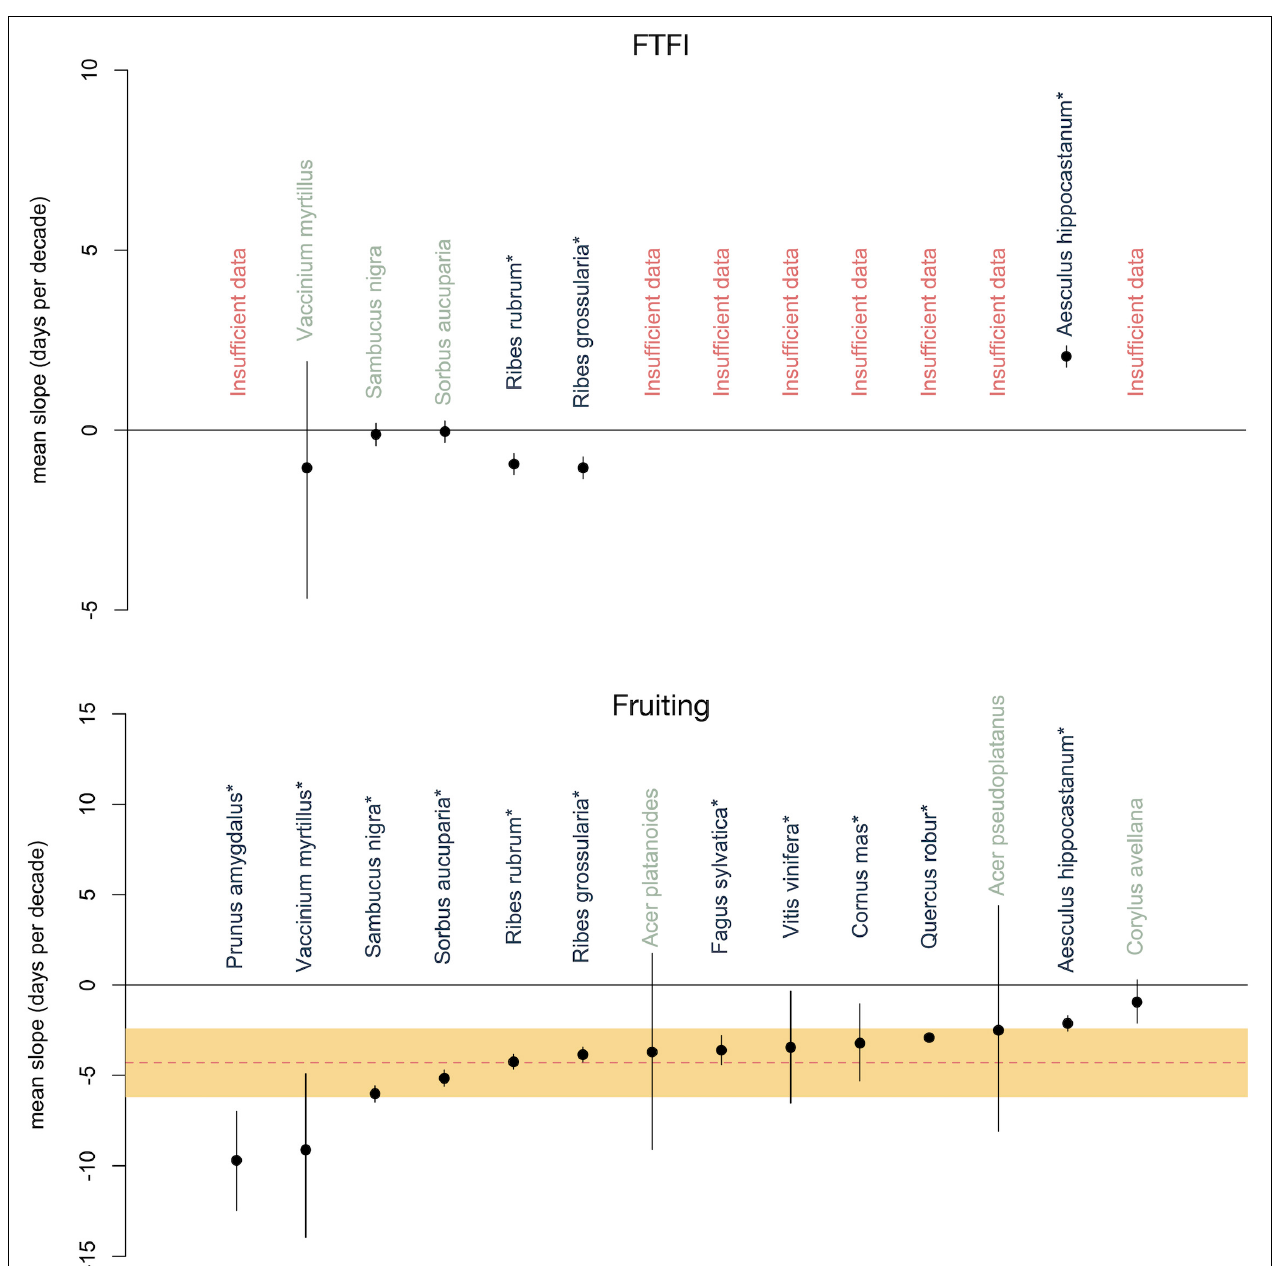
FIGURE 1 | Mean phenological changes in the flowering to fruiting interval (FTFI; top) and fruiting time (bottom) of 6 and 14 European trees and shrubs, respectively, from 1980 to 2005. Mean changes are represented with dots and 95% credible intervals are represented with bars. Species names for which the FTFI or fruiting time changed significantly are starred and in dark gray. Species names for which the FTFI or fruiting time did not significantly change are in green. Across-species mean of the shift in fruiting time (–4.2 days/decade) is denoted by the red dotted line (bottom) with the 95% credible interval in orange.